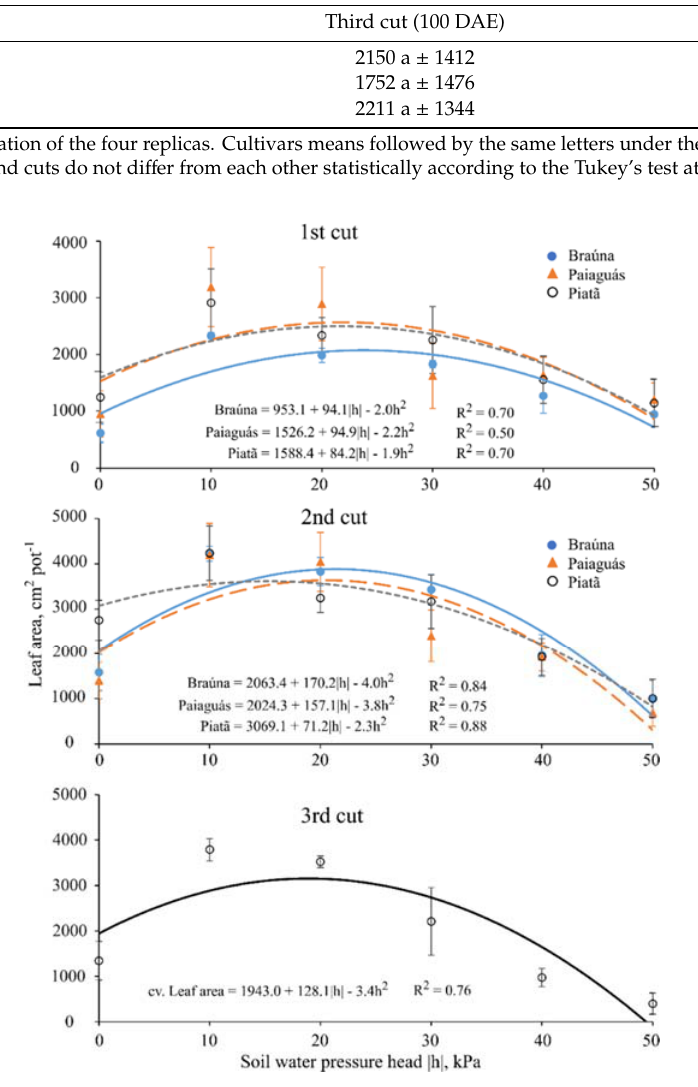
Figure 3. Regression models relating soil water pressure head to leaf area of Brachiaria brizantha cultivars for the three cutting periods (40, 70, and 100 DAE). Error bars correspond to the standard deviation of the four replicas.